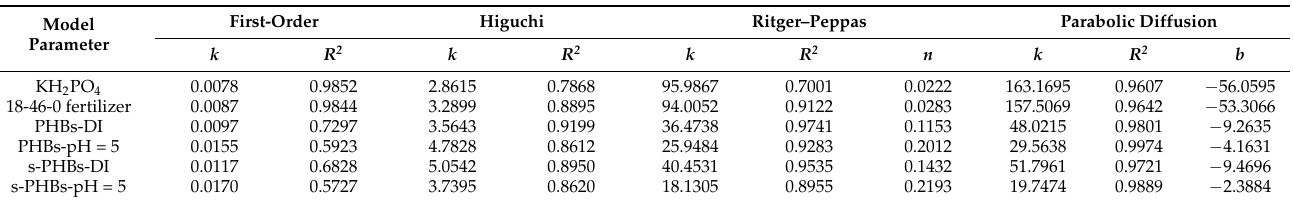
Figure 7. Linear plots of kinetic models for phosphate release of ( a ) KH 2 PO 4 , ( b ) DAP, ( c ) PHBs-DI, ( d ) PHBs-pH = 5, ( e ) s-PHBs-DI, and ( f ) s-PHBs-pH = 5: ( A ) first-order, ( B ) Higuchi, ( C ) Ritger – Peppas, and ( D ) parabolic diffusion. Table 1. Kinetic fitting parameters of each mathematical model for the phosphate release of all samples.